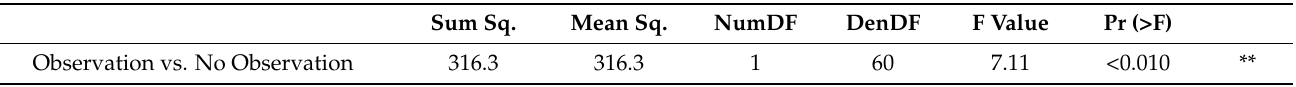
Figure 3. Overall behavioral findings: ( a ) the task-duration results indicated a highly significant effect of perceived observation for the BVRT task, but no significant effect of perceived observation for the VPT task. ( b ) No significant effects of perceived observation were found when analyzing task accuracy, though this may be due to a ceiling effect, particularly for the VPT task where the mean scores were very high at 96%. ** indicates p < 0.01. Table 2. Type III analysis of variance table with Satterthwaite’s method of condition on duration. A significant difference between task durations was observed when comparing participants who were observed with those that were not observed. No significant effect of task format was observed. ** indicates p < 0.01. Definitions. Sum of Sq: Sum of Squares. Mean sq: Mean Squares, NumDF: Numerator, Degrees of Freedom. DenDF: Denominator, Degrees of Freedom. Sum Sq. Mean Sq. NumDF DenDF F Value Pr (>F) Observation vs. No Observation